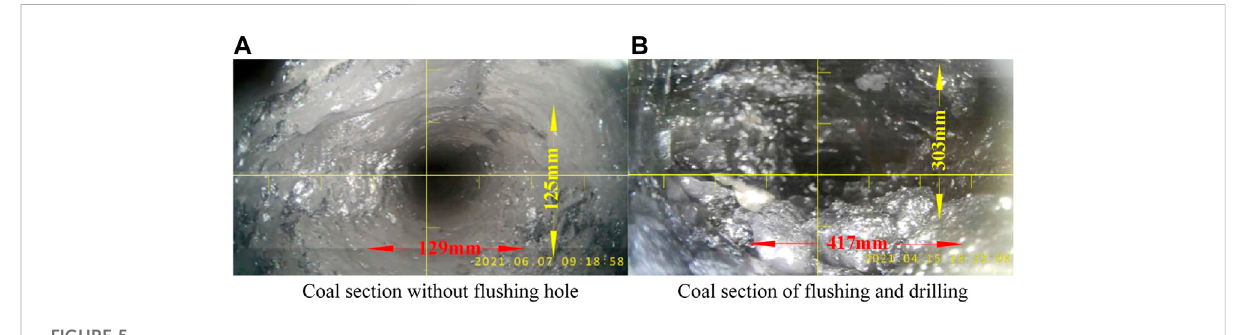
FIGURE 5 Borehole aperture peep view. (A) Coal section without fl ushing hole. (B) Coal section of fl ushing and